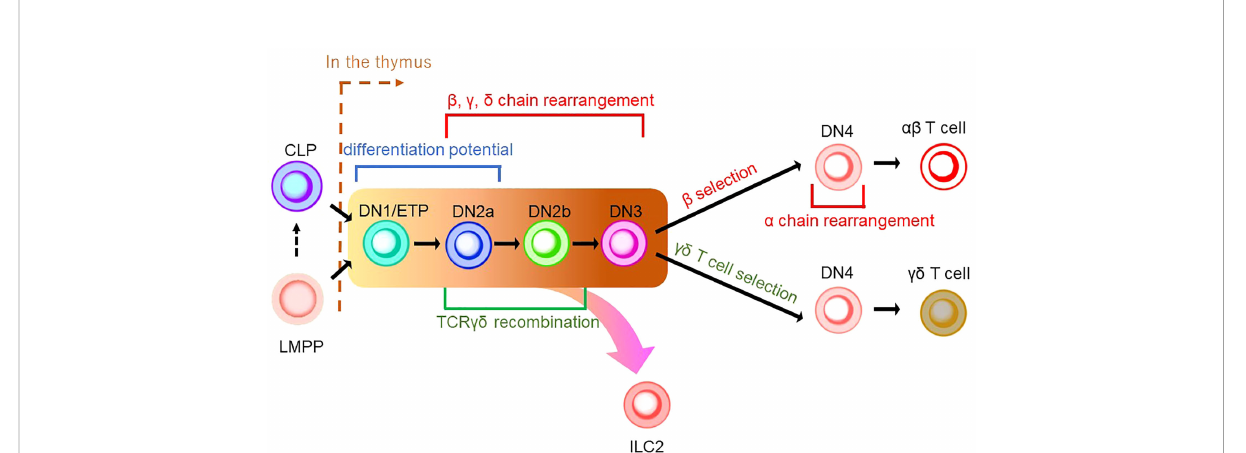
FIGURE 2 A schematic model of thymic development of T-cell lineages. CLP or LMPP is seeded into the thymus to become a thymocyte (the right side of a brown dashed line indicates thymic development). Thymocyte develops from a series of double-negative (DN) cells. ab T cells and gd T cells share the same developmental pathway from DN1/ETP to DN3 (indicated by the background in yellow to brown). DN1/ETP and DN2a harbor the differentiation potential as EILP in mice and EToP1/2 in humans (see Figure 1). T-cell receptor (TCR) recombination occurs during DN cell phases. Speci fi cally, DN2a/b and DN3 undergo recombination of b , g , and d chains, while DN4 cells in the b -selection pathway do that of the a chain. TCR gd recombination is known to occur in the phase between DN2a/b. In DN4 stage, gd T-cell selection induces gd T-cell development, while b -selection leads to ab T-cell differentiation. ILC2 may be derived from the transition between the DN1/early thymic progenitor (ETP) and DN3 in the gd T-cell development